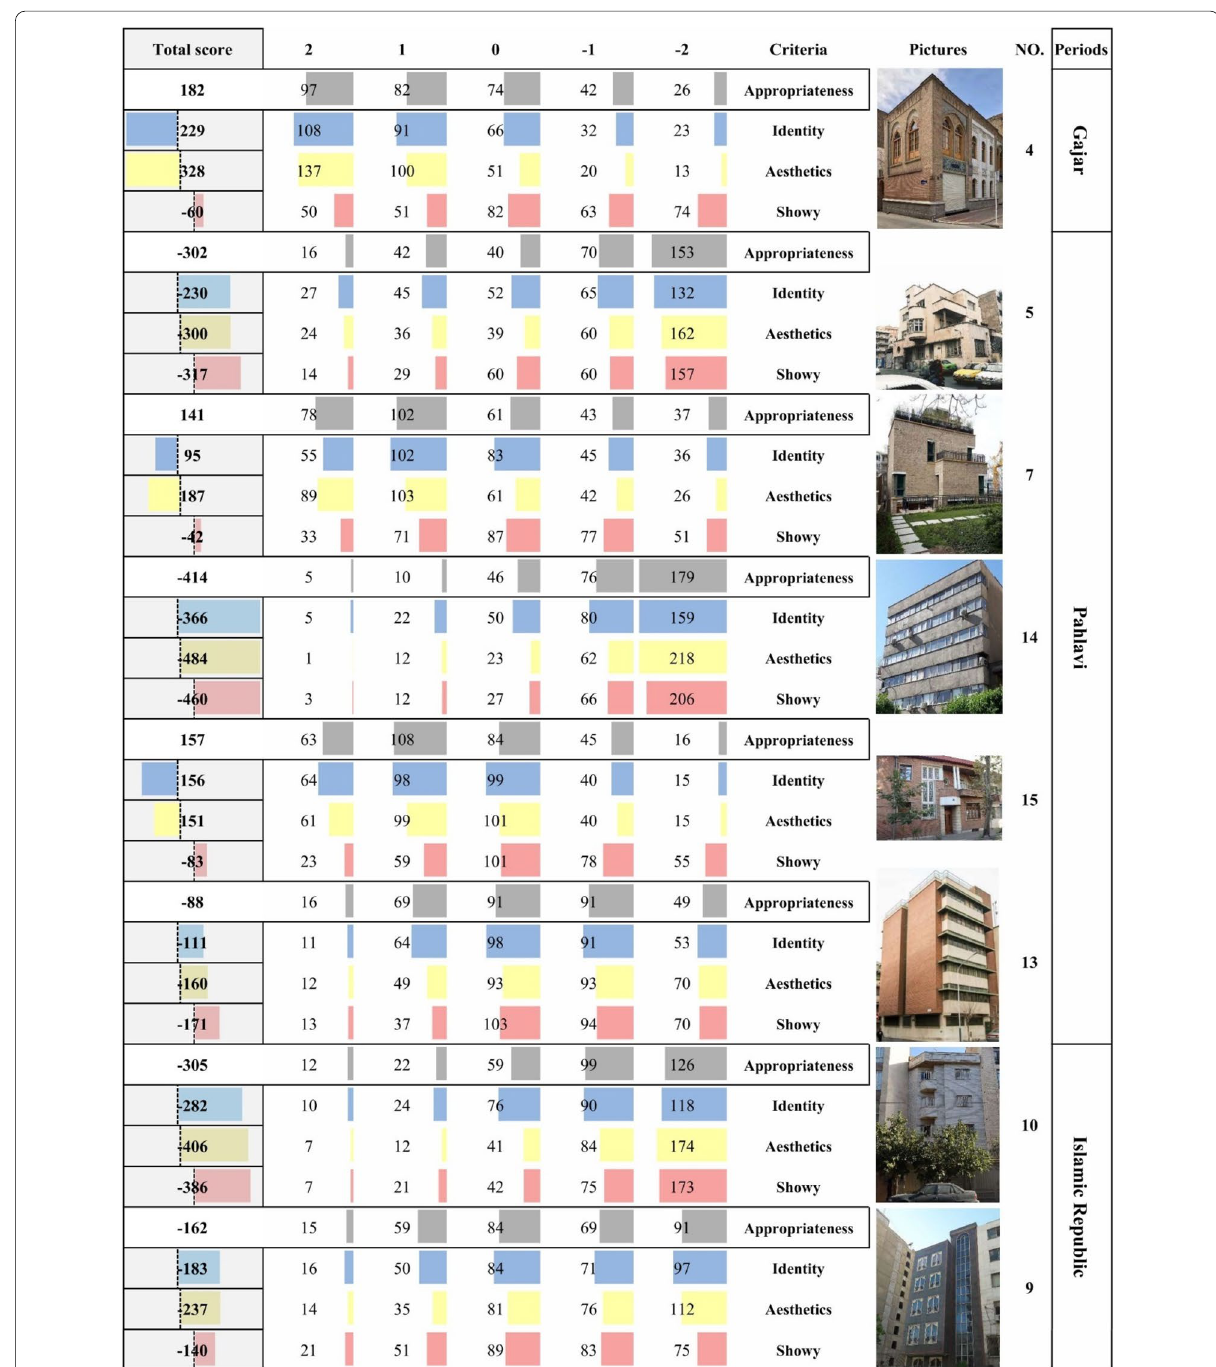
Fig. 11 People’s perception to selected façades from different